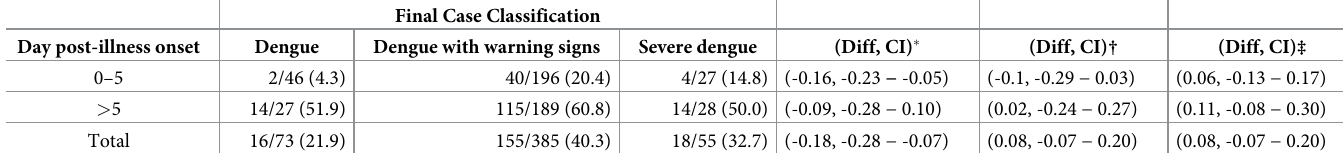
Table 3. The presence of anti-DENV IgM in urine by dengue severity. Urine anti-DENV IgM results by dengue disease classification and day post-illness onset of speci- men